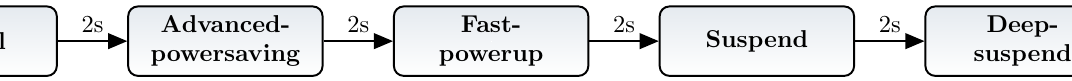
Figure 6. Control flow of gyroscope modes test.